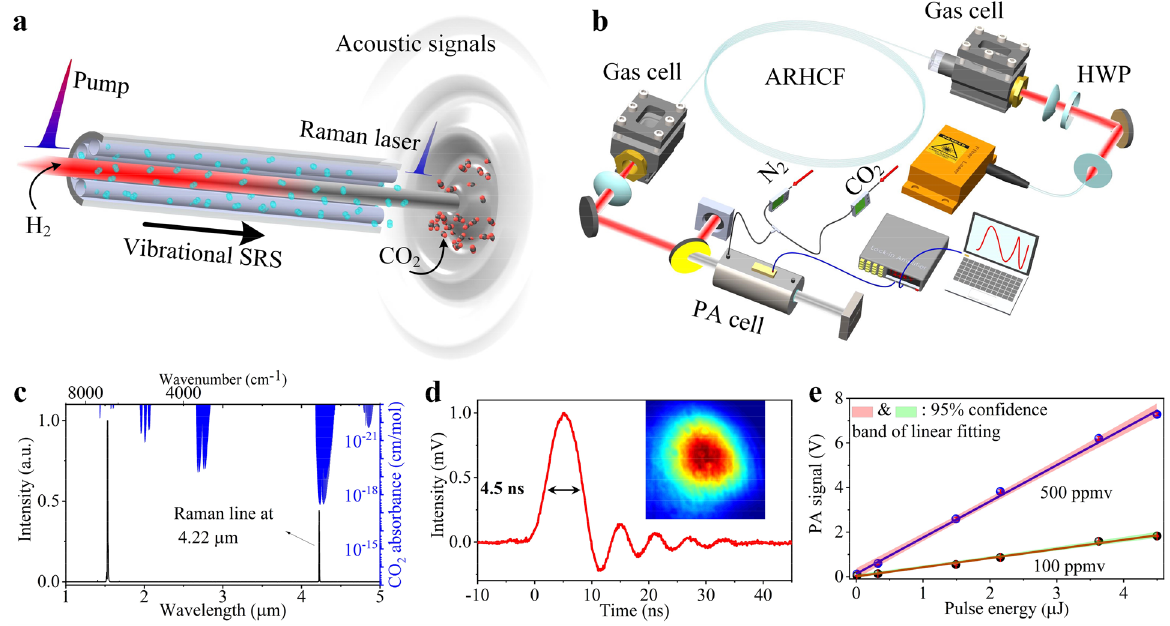
Figure 1. Principle and schematic of the MIR PA CO 2 monitoring. ( a ) Concept of the PA system integrated with an H 2 -filled ARHCF based MIR Raman laser. ( b ) Experimental setup, primarily consisting of a pump laser, H 2 -filled ARHCF, PA cell, a power meter to record the optical power of the laser, a LIA and a dynamic N 2 / CO 2 gas-flow configuration. ( c ) The spectrum of the pump and generated laser overlaid on top of the simulated absorbance spectrum of CO 2 . The right axis shows the simulated absorbance spectrum of CO 2 . ( d ) Pulse profile of the Raman laser; Inset is the measured beam profile in the MIR. ( e ) Measured PA intensity as a function of the laser pulse energy at two different CO 2 concentrations (500 ppmv and 100 ppmv). Shaded regions correspond to the 95% confidence band for every